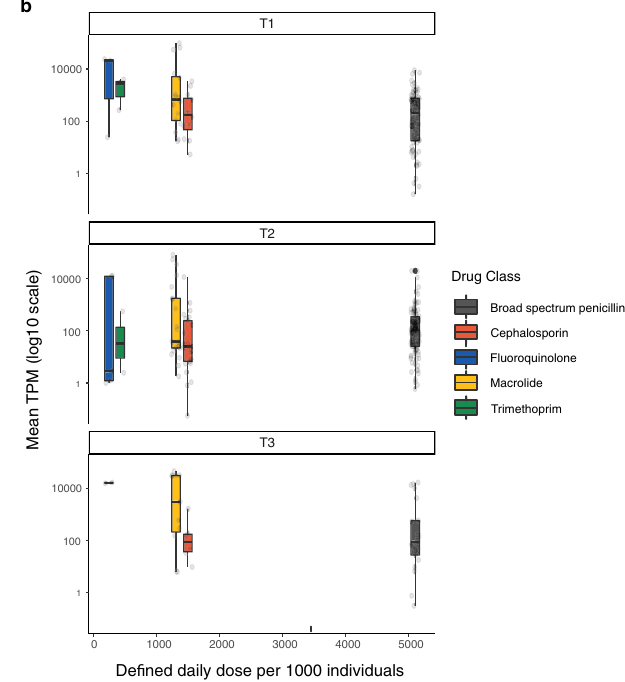
TableS3). b BoxplotsofmeanrelativeabundanceofARGscalculatedastranscripts per million (TPM) for each AMR gene class against de fi ned daily dose/1000 indi- viduals from 2017 for Australia 69 per time point. Centre line of the boxplot repre- sents the median, the minima and maxima of the box length corresponds to the fi rst and third quartiles (the 25th and 75th percentiles), whiskers extend from the box to no further than 1.5*IQR (interquartile range) from the hinge. Data beyond the end of the whiskers are plotted